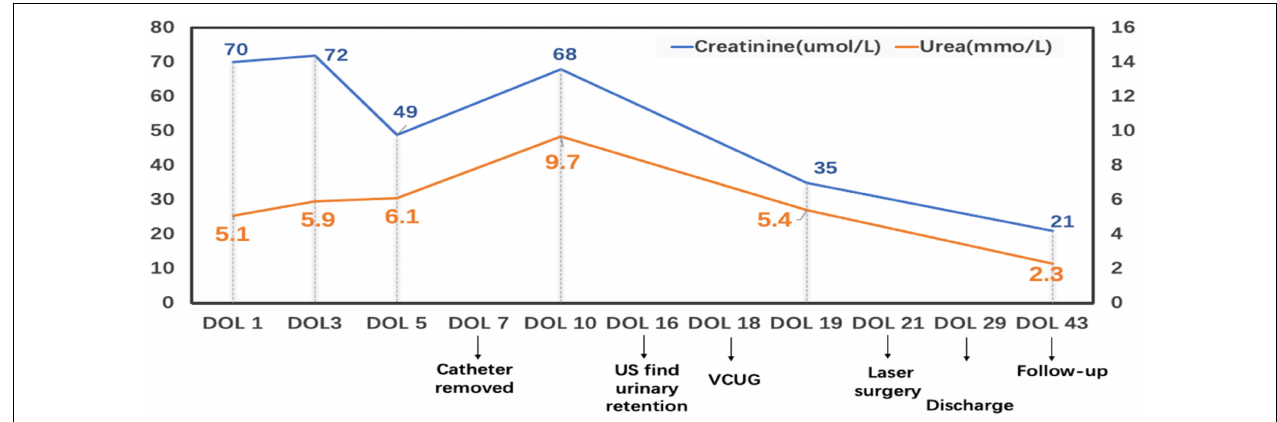
FIGURE 2 | This broken line graph shows the variation of the blood urea and creatinine during the hospital and follow-up. DOL: Day of life; US: ultrasound; VCUG: Voiding cystourethrogram.